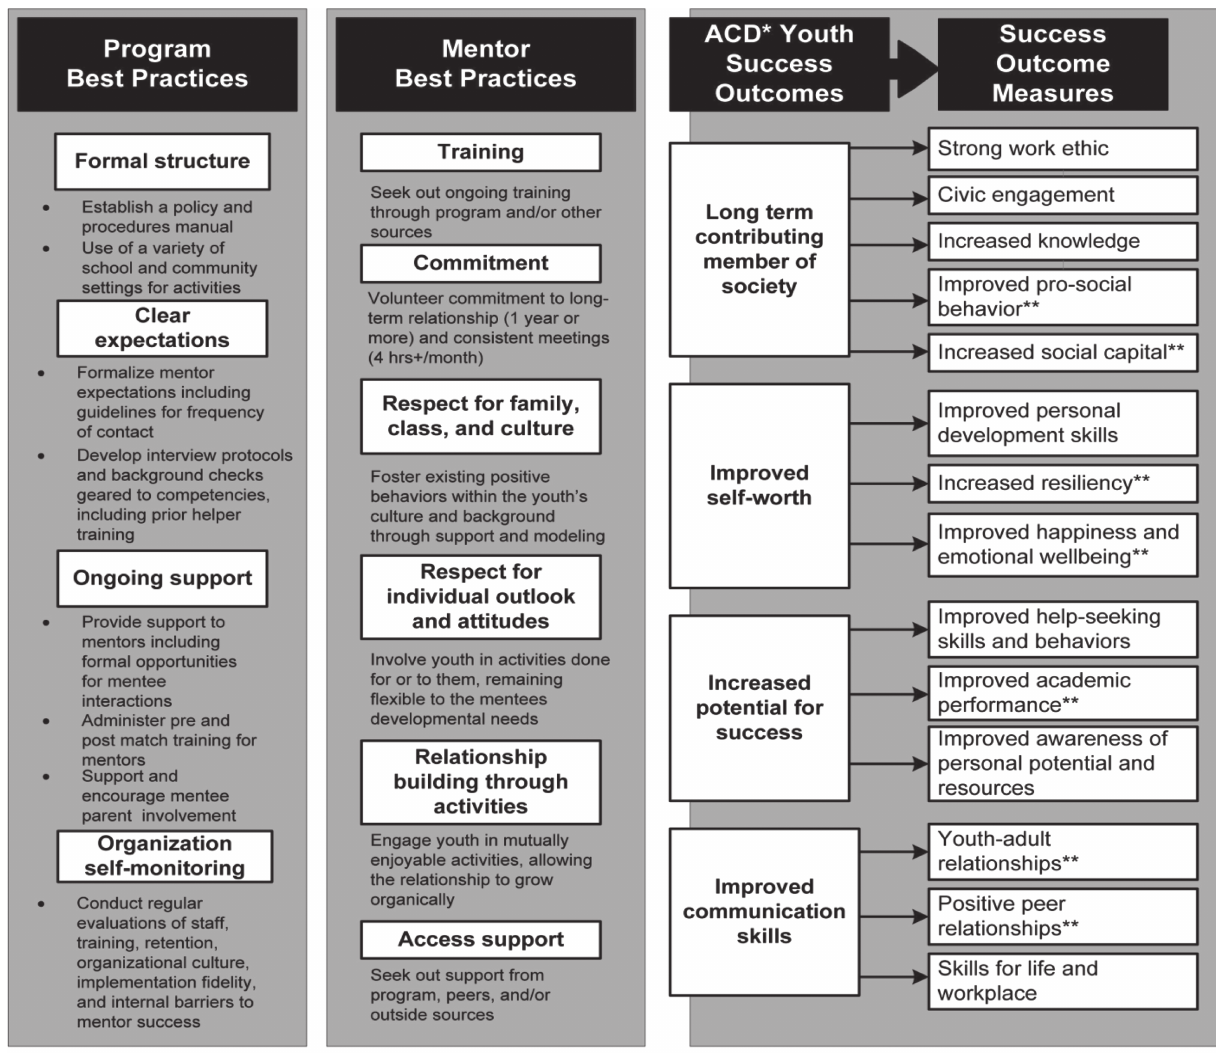
Figure 1. Mentoring Program Practices, Mentor Practices, and Youth Success Factors (Anastasia & Drever,